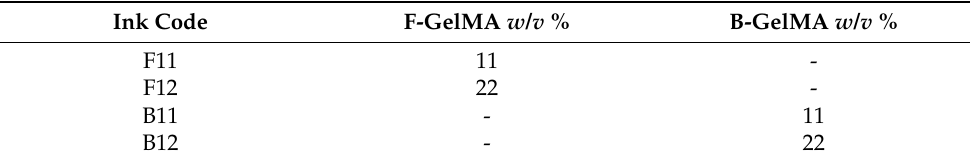
Table 1. Biomaterial ink